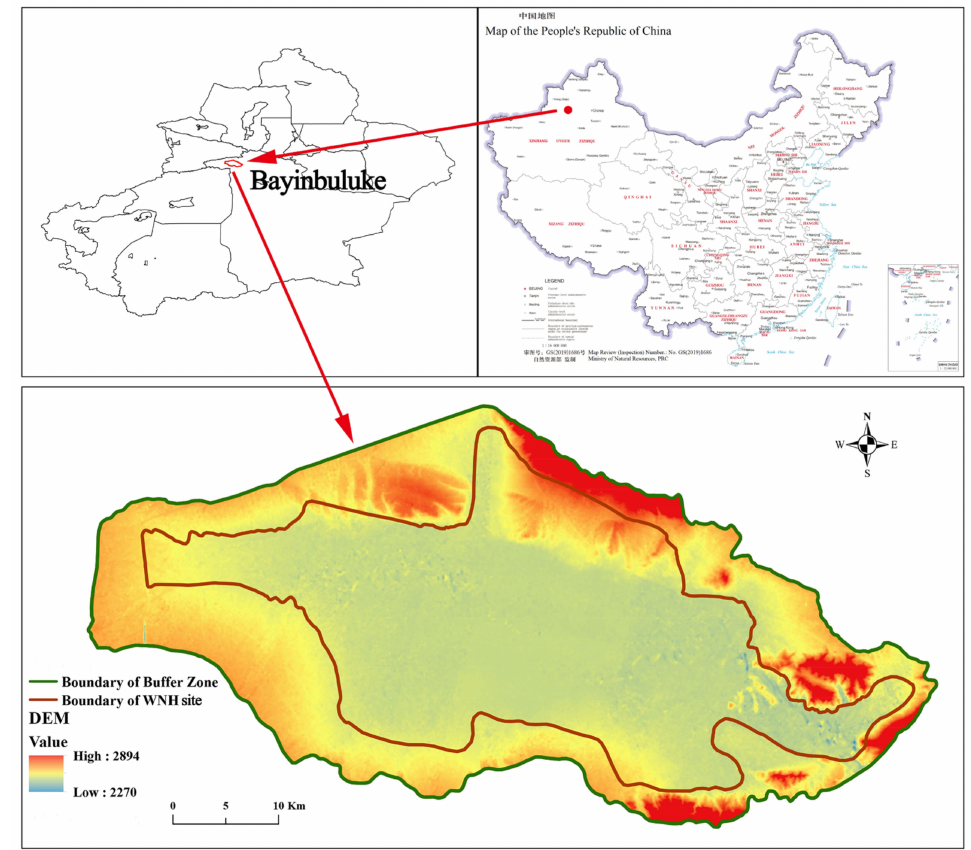
Figure 1. Location of Bayinbuluke (source: